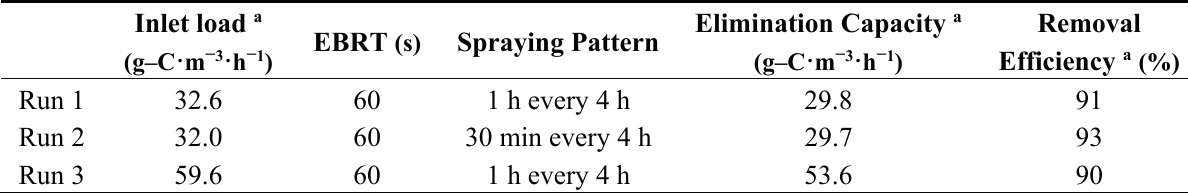
Table 1. Overall performance of the laboratory-scale experiments. EBRT, empty bed residence time.